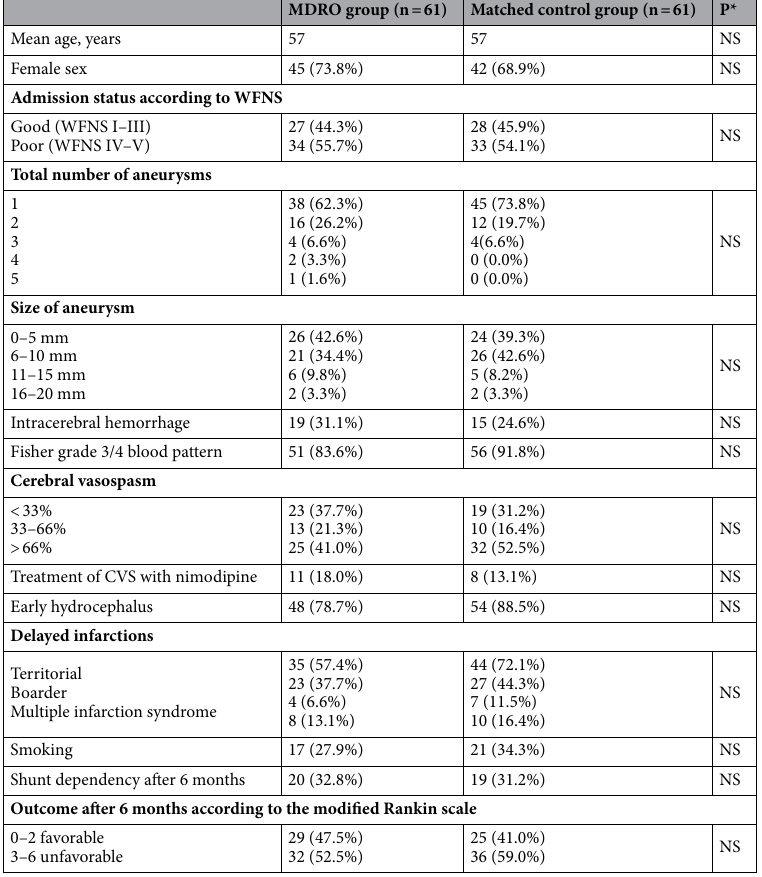
Table 1. Patient characteristics. WFNS World Federation of Neurological Surgeons, CVS cerebral vasospasm, MDRO multidrug resistant organism; categorial variables were analyzed using the Fisher exact test and unpaired t-test with Welch correlation (*) for parametric values. Probability values < 0.05 were considered statistically significant. NS, not significant (P >